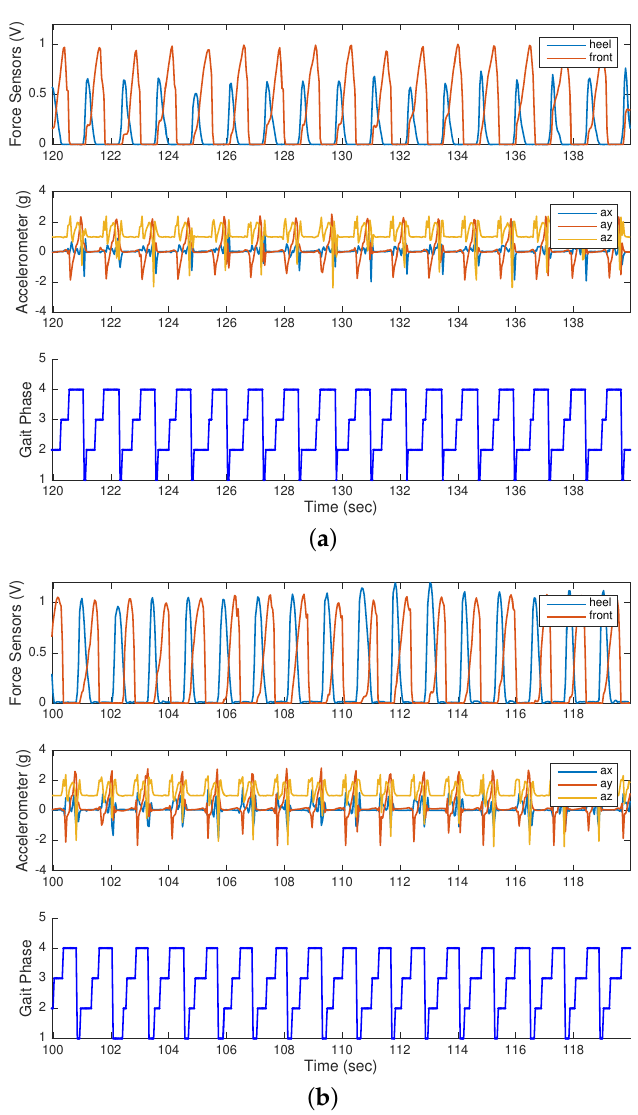
Figure 4. Typical output of the gait phase detection algorithm for two different subjects. Each subfigure - (a) and (b) - reports the sensor signal and the gait phase detection for one subject. In the top graphs, the force value F h and F f are reported. The middle figures report the calibrated accelerometer components ( ax , ay , az ). The bottom traces are related to the detected gait